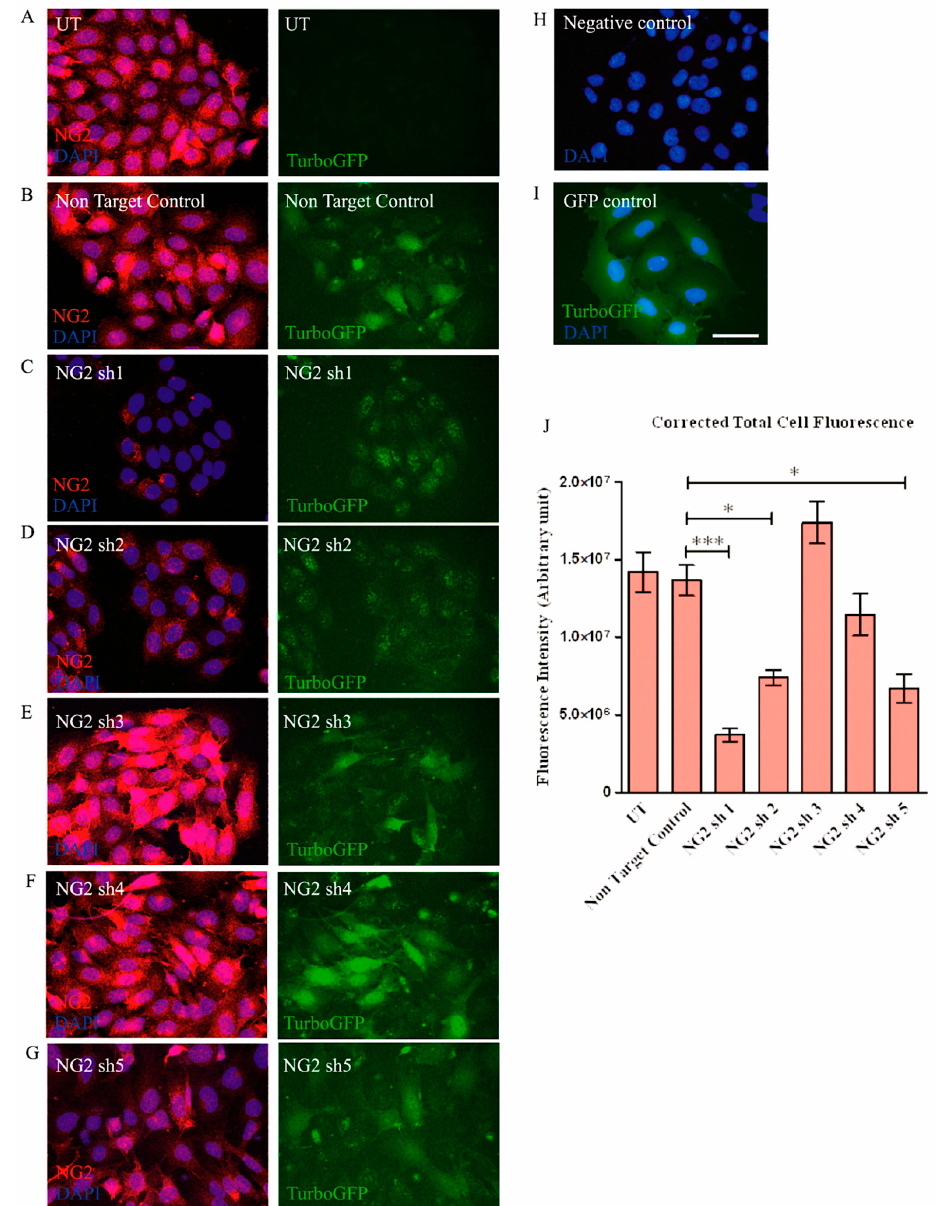
Figure 4. NG2 sh1, NG2 sh2 and NG2 sh5 lentiviral vectors significantly reduce NG2 protein in Neu7 cells in vitro. Photomicrographs show representative projected confocal images of corrected total fluorescence of untransduced control ( A ), non-targeting control ( B ), NG2 sh1 ( C ), NG2 sh2 ( D ), NG2 sh3 ( E ), NG2 sh4 ( F ), NG2 sh5 ( G ), negative control (no primary antibody) ( H ) and GFP control ( I ) after 10 days of puromycin selection. Graph shows the corrected total cell fluorescence of NG2 protein ( J ). Scale bar = 50 µm. Mean ± SEM. * p ≤ 0.05, ** p ≤ 0.01, *** p ≤ 0.001. n = 3. Tukey’s post-hoc test using one-way ANOVA. Significance is reported in comparison to the cells transduced with the non-targeting control.